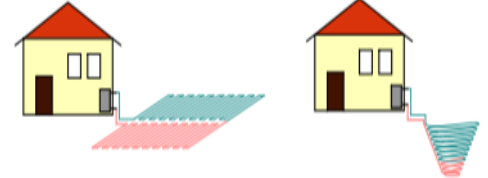
Figure 7. Horizontal collectors and heat baskets [94] (p. 240).